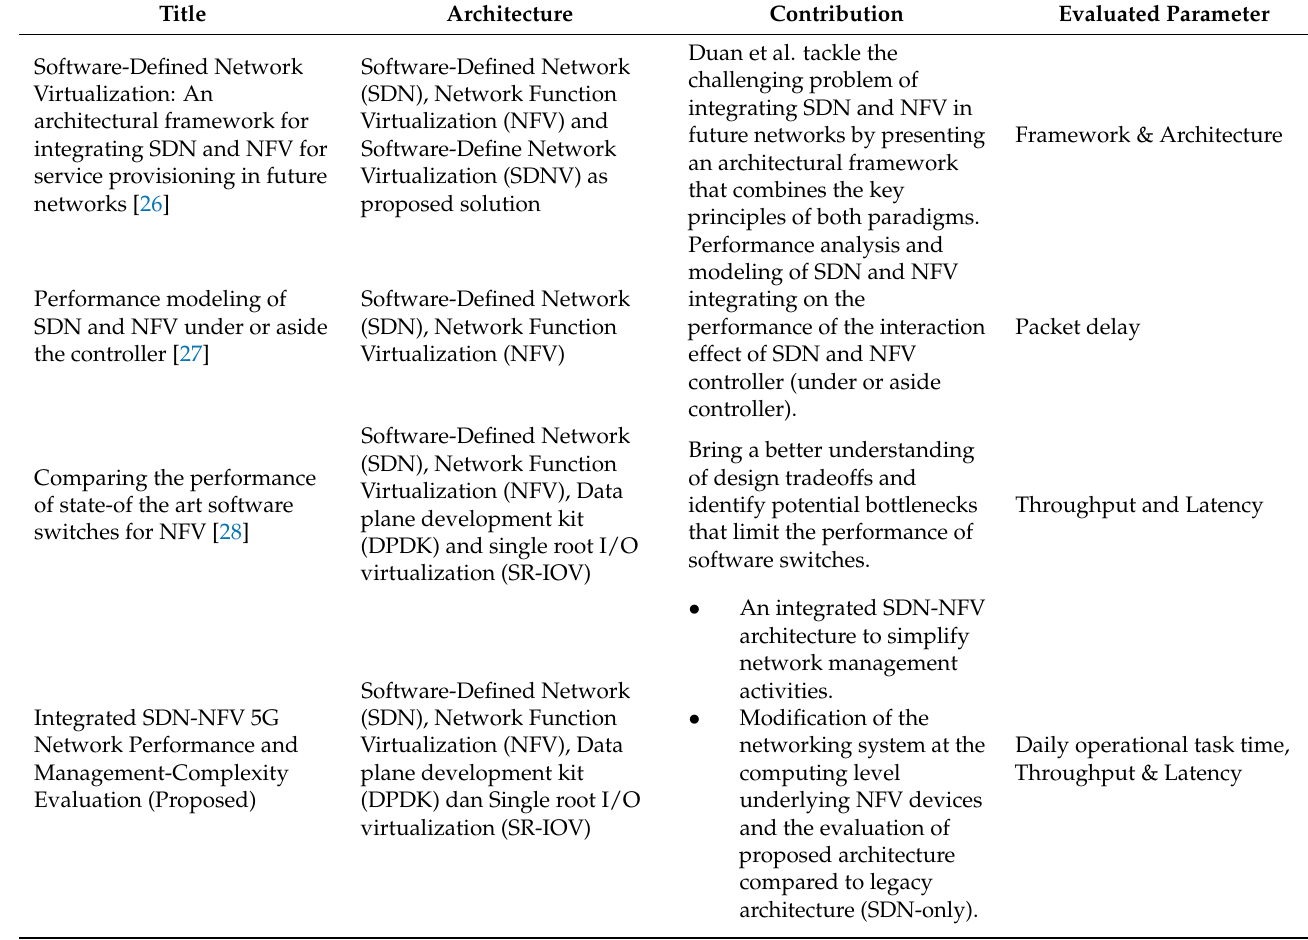
Table 1. Comparison of SDN-NFV integration which related to this